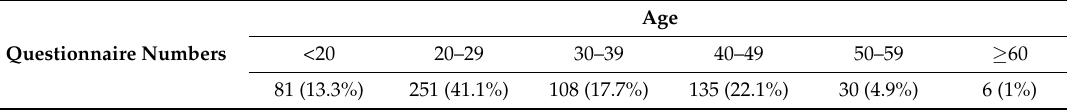
Table 1. Demographic results of questionnaire survey.